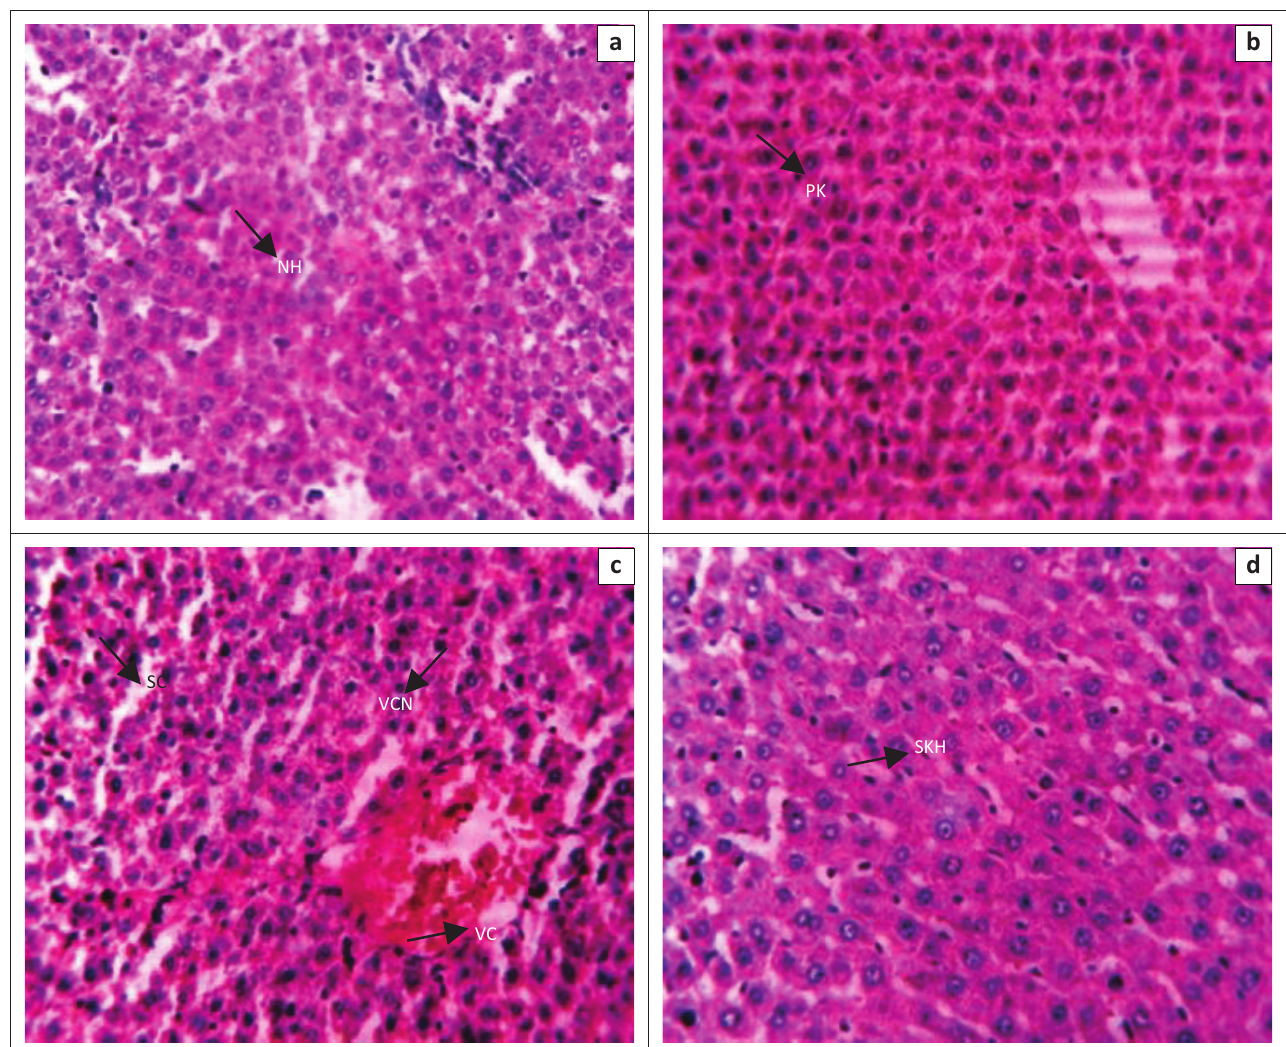
NH, normal hepatocytes; VCN, vascular congestion necrosis; SC, sinusoidal congestion; PK, pyknosis of hyptocytes nucleus; SKH, Kupfer cell hyperplasia; VC, slight vacuolation necrosis. FIGURE 4: Photomicrograph showing the liver section of (a) control group (1 mL/kg distilled water) shows the normal hepatocytes; (b) treated with 500 mg/kg shows moderate pyknosis of hepatocytes nucleus; (c) treated with 1000 mg/kg shows vascular congestion sinusoidal congestion and slight vacuolation necrosis; (d) treated 1500 mg/kg shows slight Kupfer cell hyperplasia (haematoxylin and eosin stain; original magnification ×